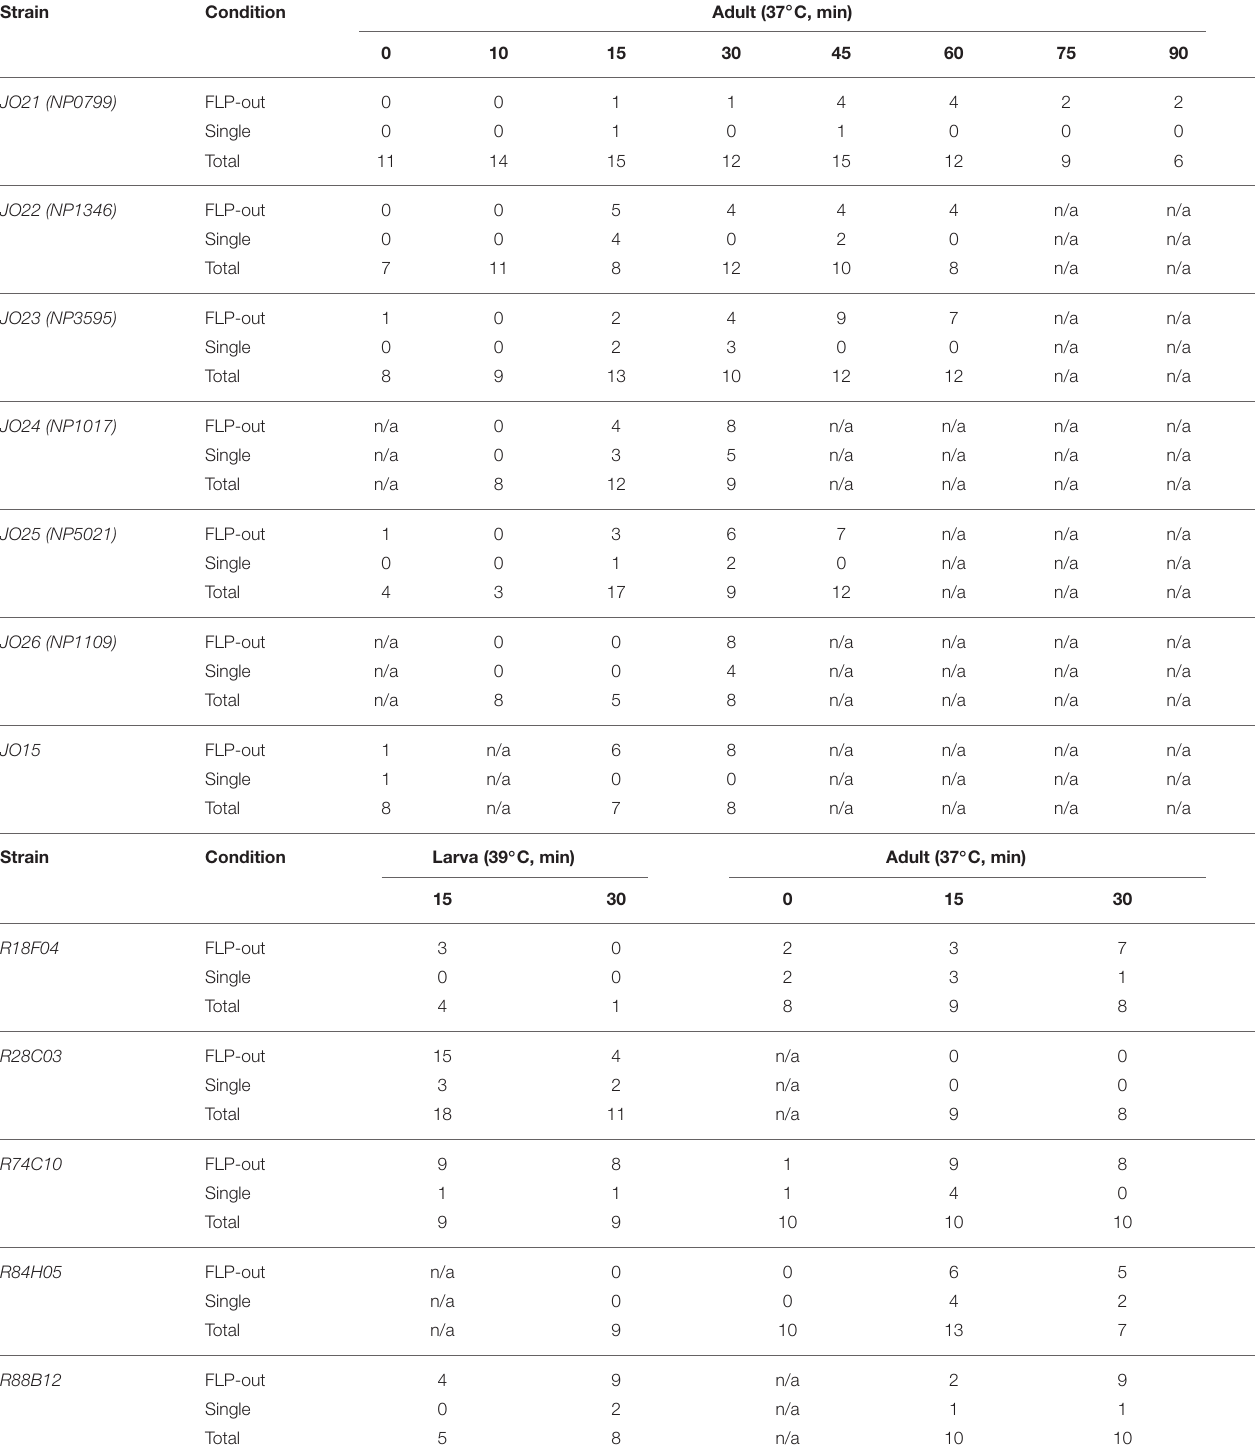
TABLE 1 | Optimal heat-shock condition in each GAL4 strain.